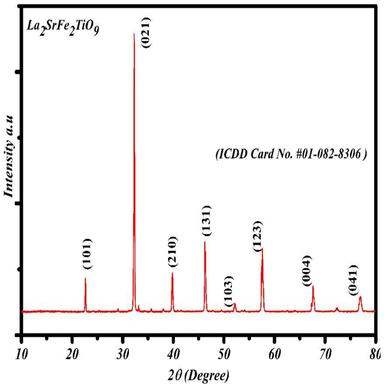
XRD pattern of the sample La2SrFe2TiO9.